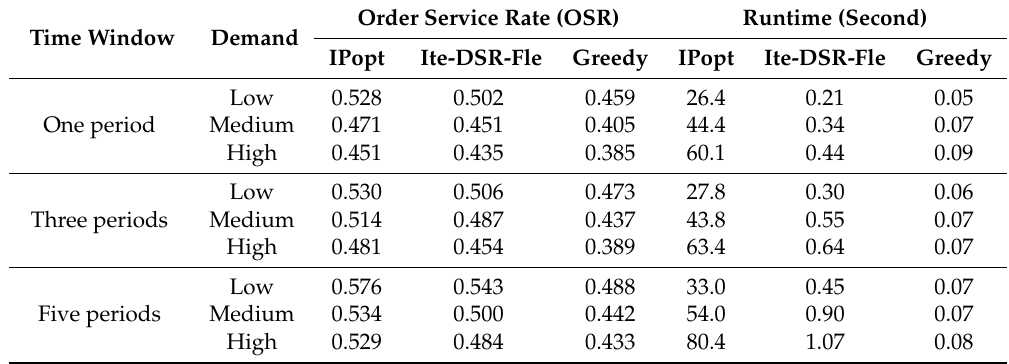
Table 2. OSR and running time on small-scale instances. To make the table clear, we omit the statistical errors, and each cell is statistically significant at a 95% confidence